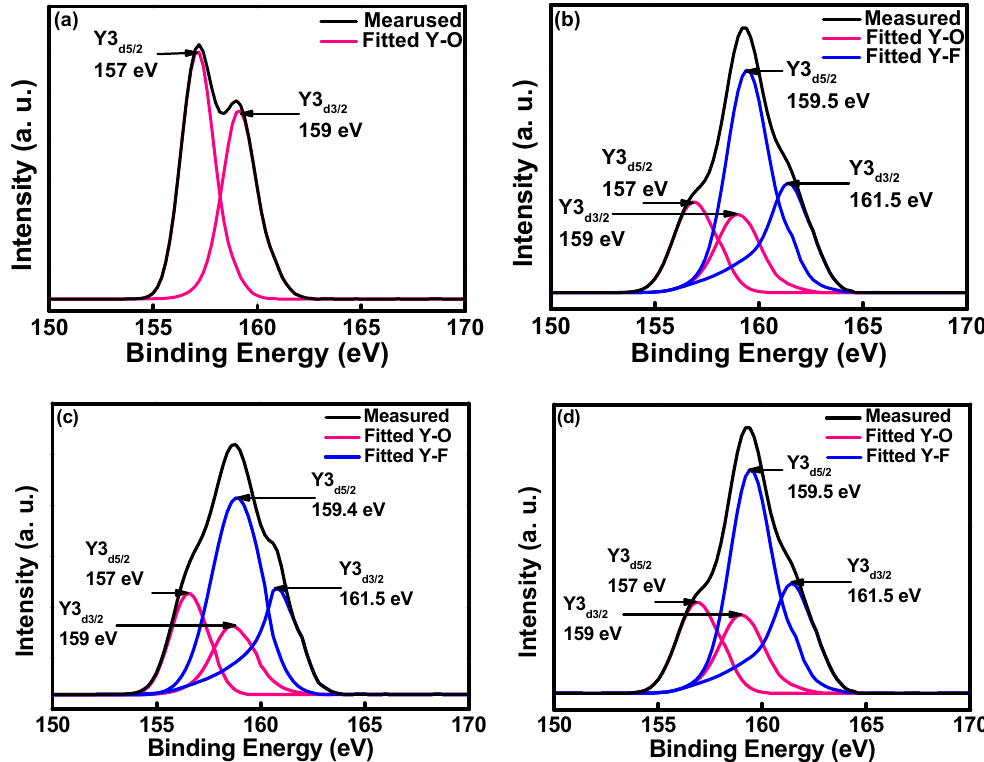
Figure 5. X-ray photoelectron spectra of ( a ) and ( b ), the as-deposited Y 2 O 3 films before and after fluorocarbon plasma etching, respectively, and ( c ) and ( d ), the SF 6 plasma-treated films before and after fluorocarbon plasma etching, respectively.